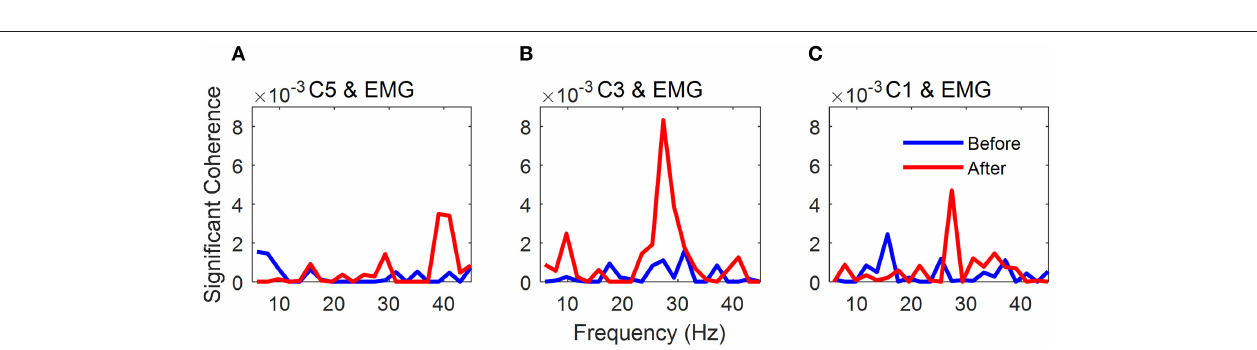
FIGURE 3 | EEG-EMG coherence. P1 to P13 indicate Participant 1 to Participant 13, the blue line indicates coherence before NMES, while the red line indicates coherence after NMES.